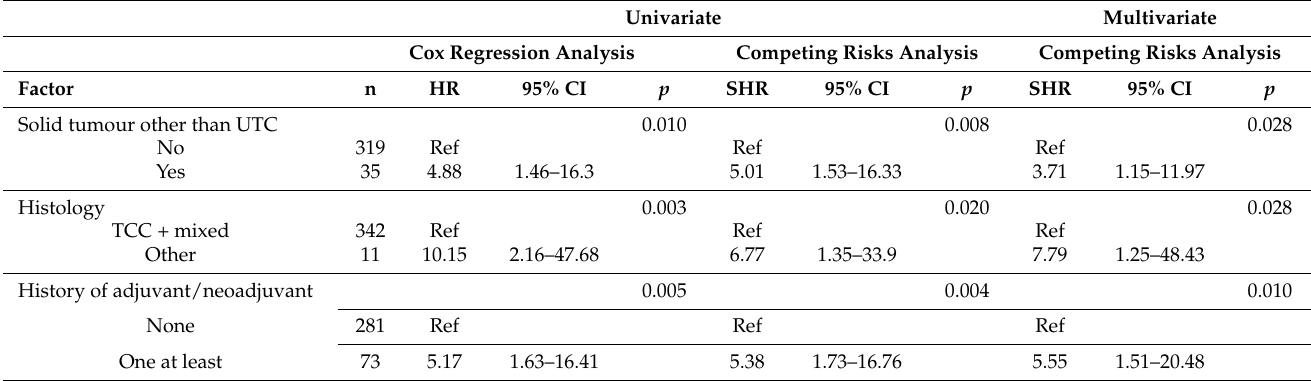
Table 3. Univariate, multivariate, cox and competing risk regression analysis of arterial thromboem- bolism based on clinical characteristics. Variables with p < 0.200 are